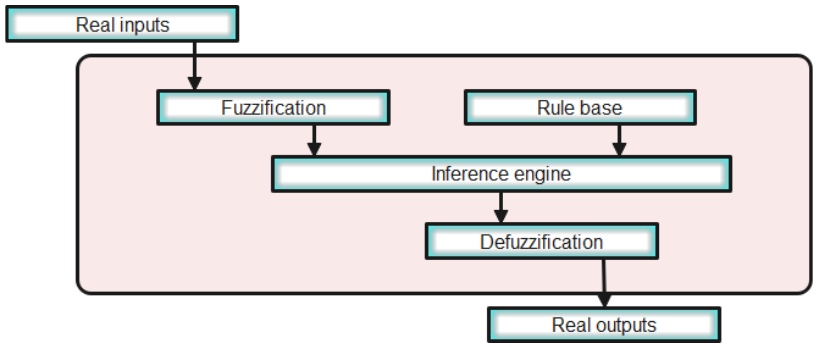
Figure 7. Schematic of the mamdani Fuzzy logic system architecture. At the fuzzification step, the real input and output signals are converted to fuzzy sets. For each input and output variables, there were seven membership functions, as represented in Figure 8a–c, respectively. Triangular and trapezoidal types of membership functions are chosen in this work. This choice is based on the trial and error method. In fact, many repetitive tests are done until suitable results are obtained. The linguistic variables BN, MN, SN, Z, SP, MP, and BP indicate big negative, medium negative, small negative, zero, small positive, medium positive, and big positive, respectively. The obtained fuzzy input and output variables are then treated by an inference engine. In this work, a sum-prod inference algorithm is used. The inputs are mapped to the outputs by using the if-then rules as indicated in Table 1. The number of the rules is fixed based on the membership function number. The fuzzy output variables obtained at the inference engine step are then converted into a crisp value. In this application, a centroid defuzzification approach is used. The real duty cycle to be applied to the real system is defined by a recurrent equation, as illustrated with Equation (31). where N is an adjustable positive gain. Table 1. Rule-based table of the fuzzy logic MPPT